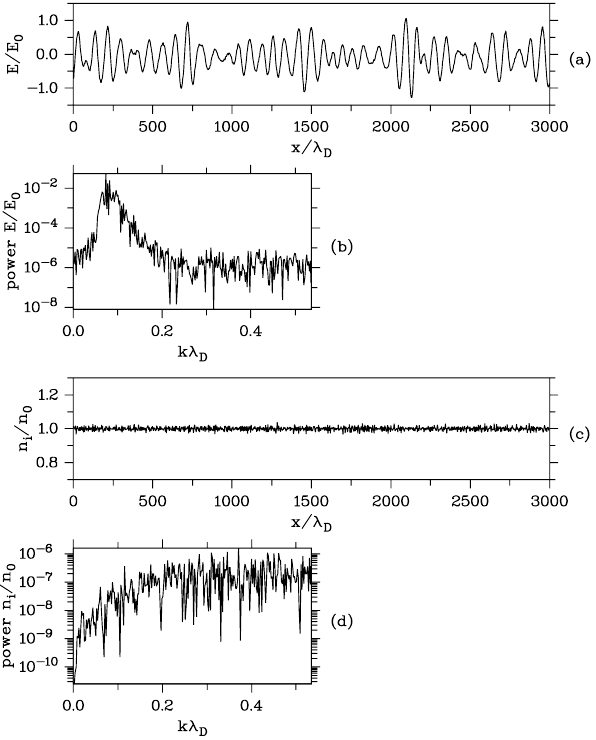
Figure 2. The same as Fig. 1 at a later time t = 600 ω − 1 pe . The most power of the low-frequency response is concentrated near kλ D ≈ 0 . 18, almost twice the wave number of the fastest growing mode, suggesting Langmuir wave decay. The power spectrum (b) is falsified by backscattered